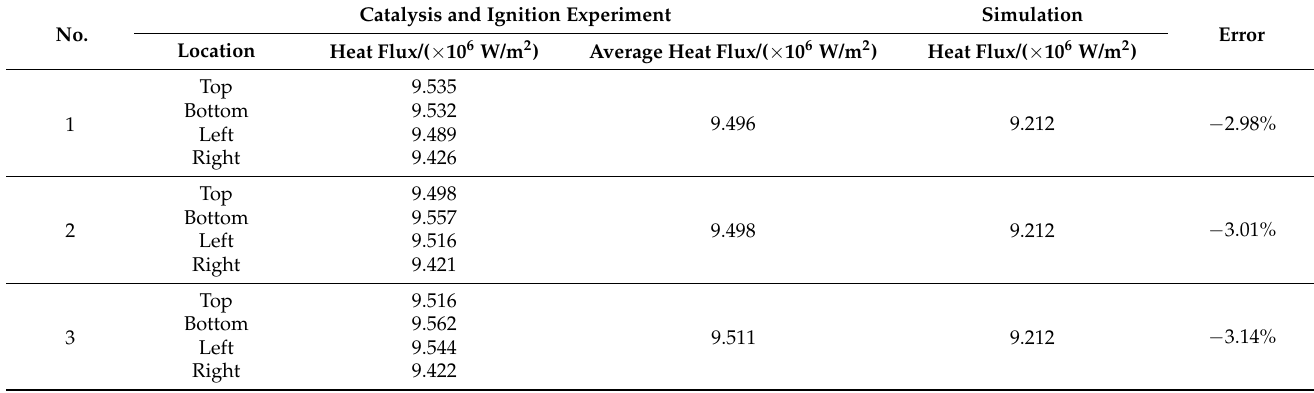
Table 3. The experiment and simulation of the heat flux at the throat of thrust chamber.